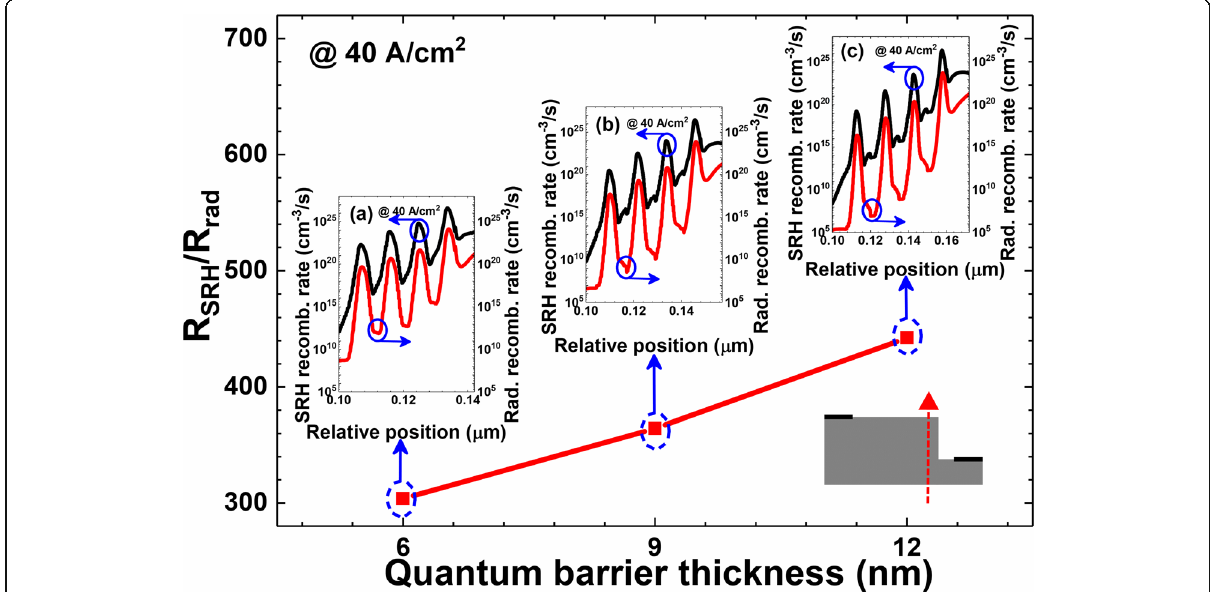
Fig. 8 Ratios of the integrated SRH recombination (SRH) rate and the integrated radiative recombination rate for μ LEDs I, II, and III. Inset figures ( a ), ( b ), and ( c ) are the profiles for SRH recombination (SRH) rate and the radiative recombination rate at the mesa edge for μ LEDs I, II, and III, respectively. Data are calculated at the current density of 40 A/cm